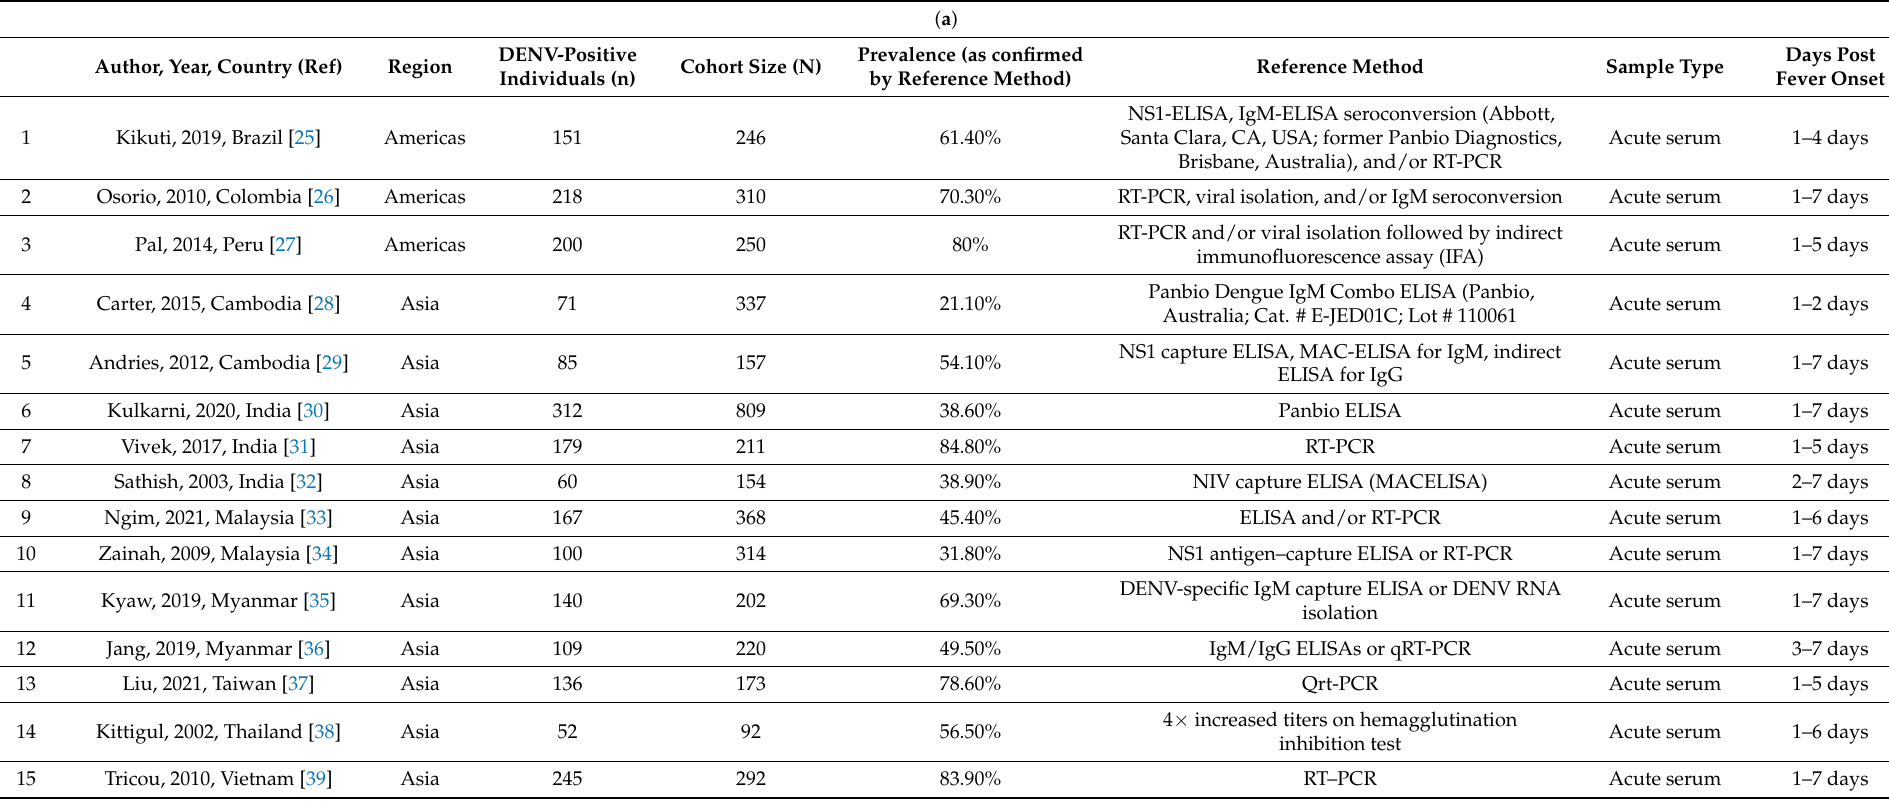
Table 2. (a) Characteristics of all the included studies. (b) Specific ICT manufacturers, sensitivity, and specificity in included primary studies. ( a